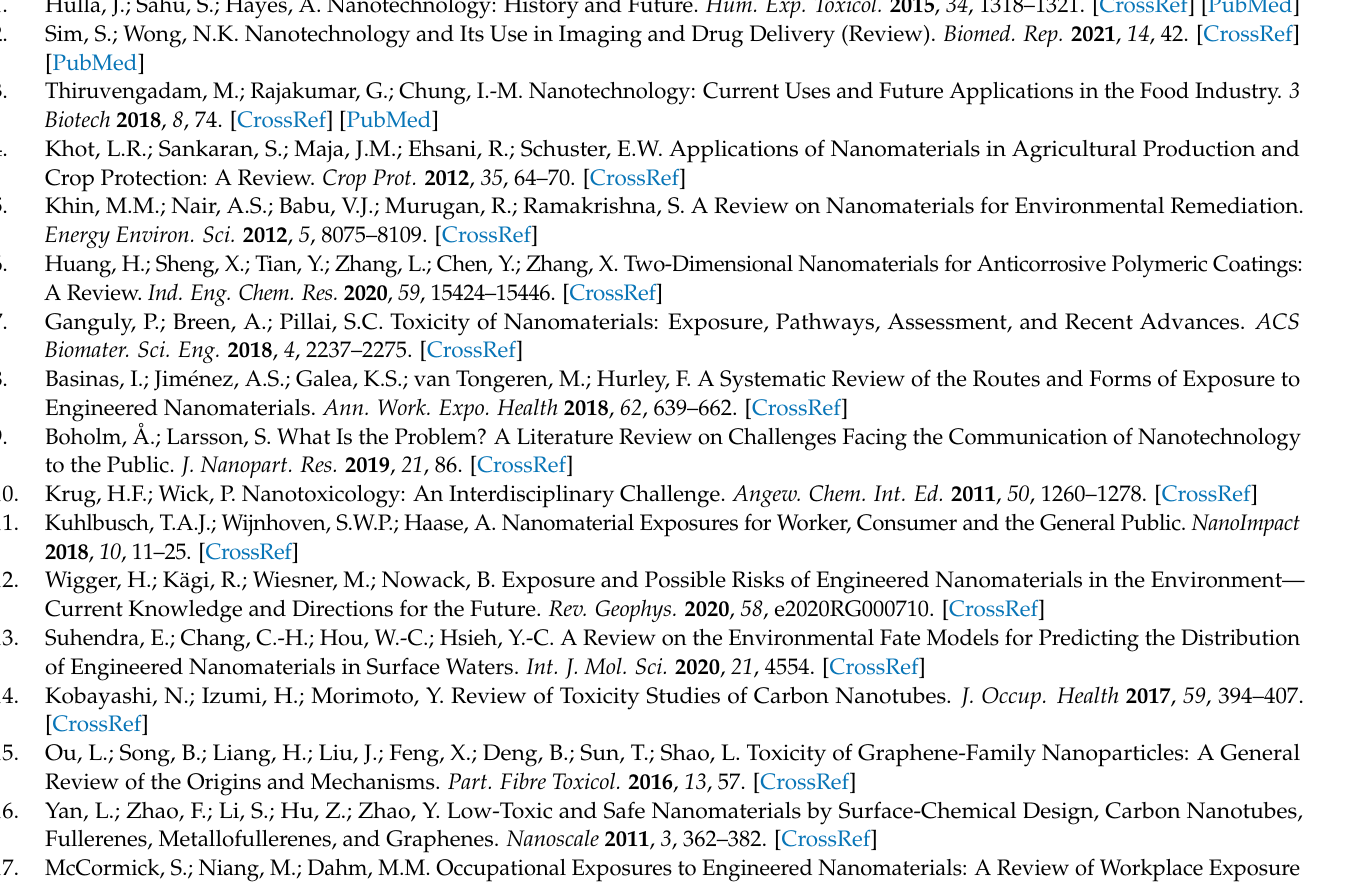
Figure S3: Total deposition fraction results for magnetite nanoparticles. Figure S4: Total deposition fraction results for SiO 2